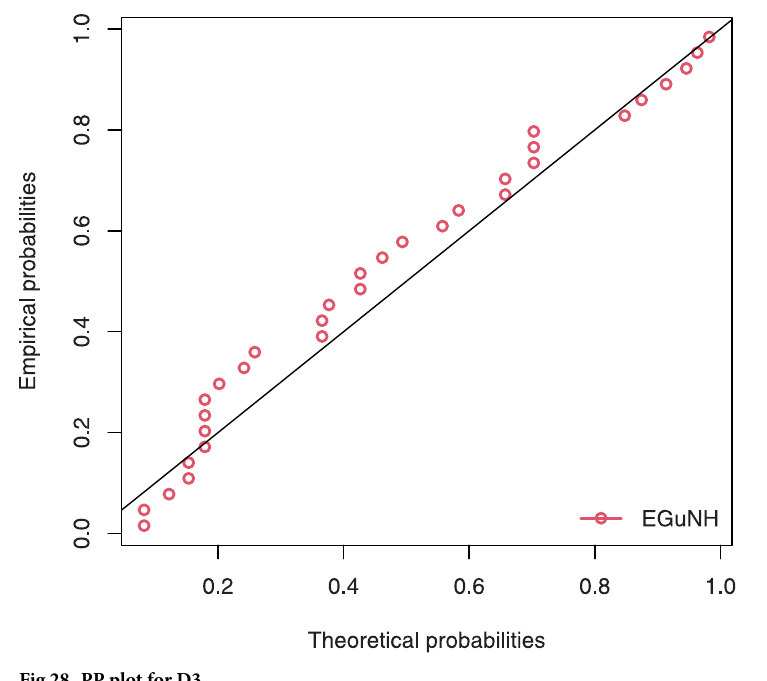
Fig 28. PP plot for